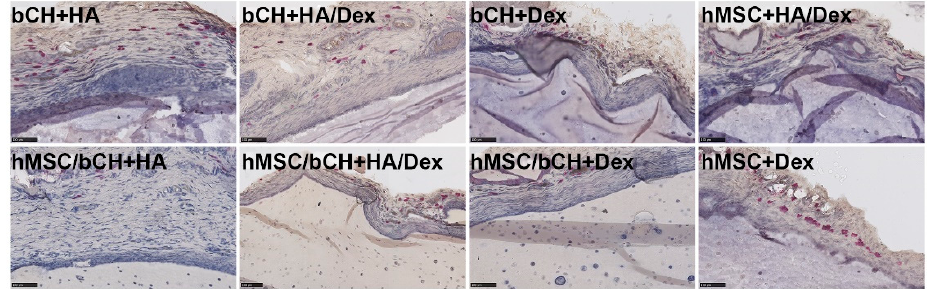
Figure 3. Neutrophil staining after 28 days of subcutaneous implantation. Representative figures of hydrogel samples with cells positively stained with chloroacetate esterase histochemistry. Positively stained cells displayed red granulation. Scale bars represent 100 μ m.